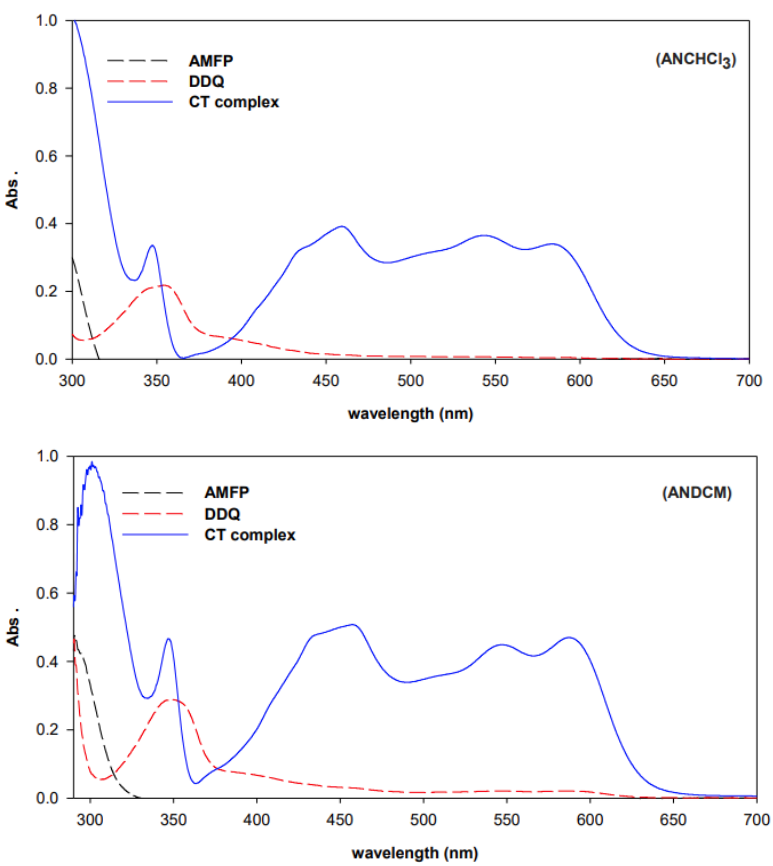
Figure 1. Electronic spectra of 1.0 × 10 − 4 mol L − 1 AMFP, 1.0 × 10 − 4 mol L − 1 DDQ, and (1:1) AMFP – DDQ CT complex in different solvents systems.